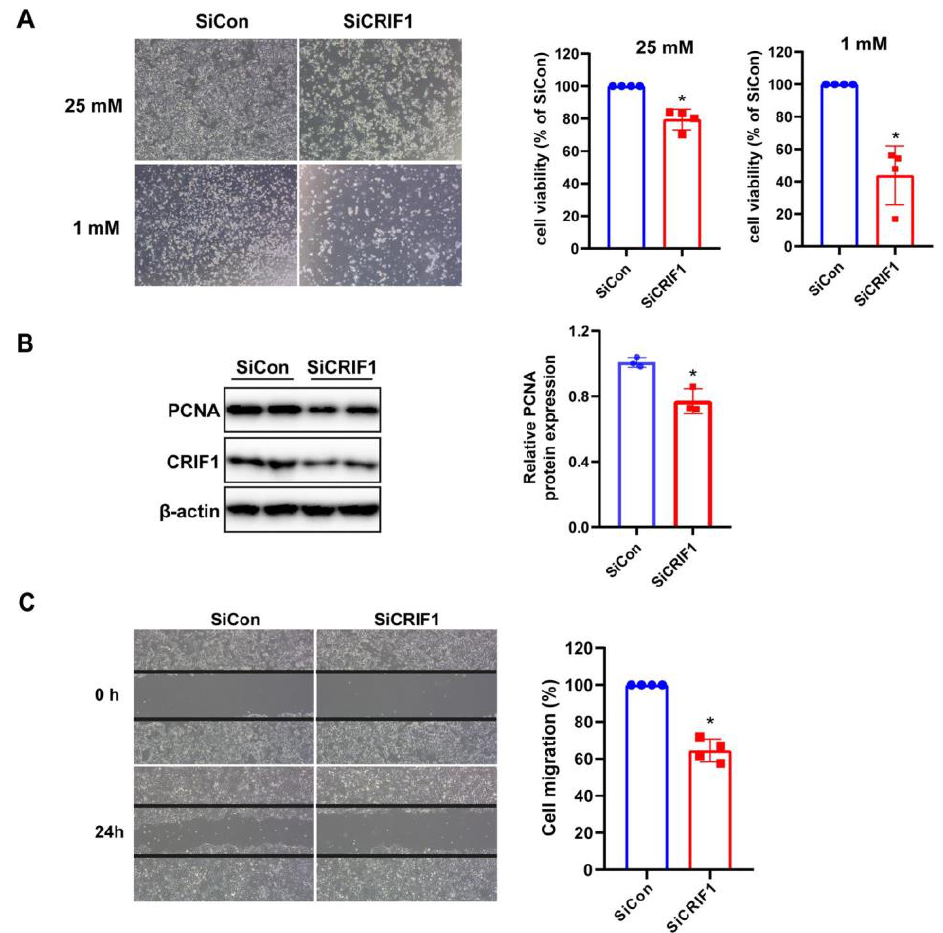
Figure 2. CRIF1 deficiency reduced MCF-7 cell proliferation and migration. MCF-7 cells were transfected with 100 pmol of siCon and siCRIF1 for 48 h. ( A ) Morphology of MCF-7 cells grown in media containing 25 mM or 1 mM glucose. Magnification, ×100. ( B ) PCNA protein level was detected by W estern blotting. β -actin was used as a loading control. Protein levels were quantified by densitometric analysis. ( C ) Cell migration was detected using the cell scratch assay. Magnification, ×40. All data are presented as means ± SEM of at least three independent experiments. * p < 0.05 compared with siCon group.